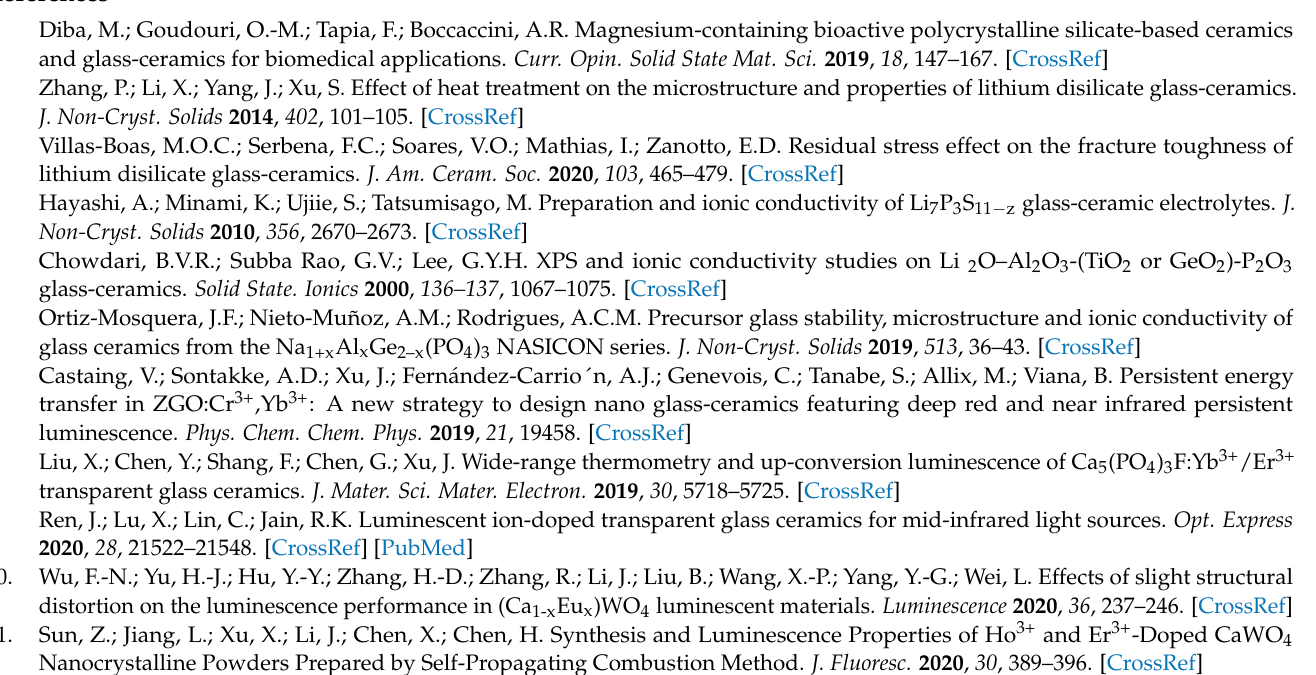
Supplementary Materials: The following are available online at https://www.mdpi.com/1996-1 944/14/4/952/s1, Figure S1: Raman spectra of the (100 − x ) (33CaO-67B 2 O 3 ) – x Ca 3 WO 6 ( x = 0 − 15) glass samples at crystalline part after the post heat-treatment.; Figure S2: Photo-image of Table 1 in the maintext.; Figure S3: PL and PLE spectra of glass (Glass), glass-ceramic (TT4d) for the 15 mol% Ca 2.98 Eu 0.02 WO 6 samples, and Ca 0.98 Eu 0.02 WO 4 crystal (xxPwd). The glass-ceramic was composed of CaWO 4 crystals. The assignments of the optical transitions were given in the figure according to the literature (W.T.Canall, P.R.Fild, and K.Rajnak, “Electronic Energy Levels of the Trivalent Lanthanide Aquo Ions. IV. Eu 3+ ”, J.Chem.Phys. 49(10) (1968) 4450–4455).; Figure S4: Enlarged PL spectra of 5 D 0 - 7 F 1 and 5 D 0 - 7 F 2 transitions normalized by 613 nm PL intensity for the glass (Glass), glass-ceramic (TT4d) for the 15 mol% Ca 2.98 Eu 0.02 WO 6 samples, and Ca 0.98 Eu 0.02 WO 4 crystal